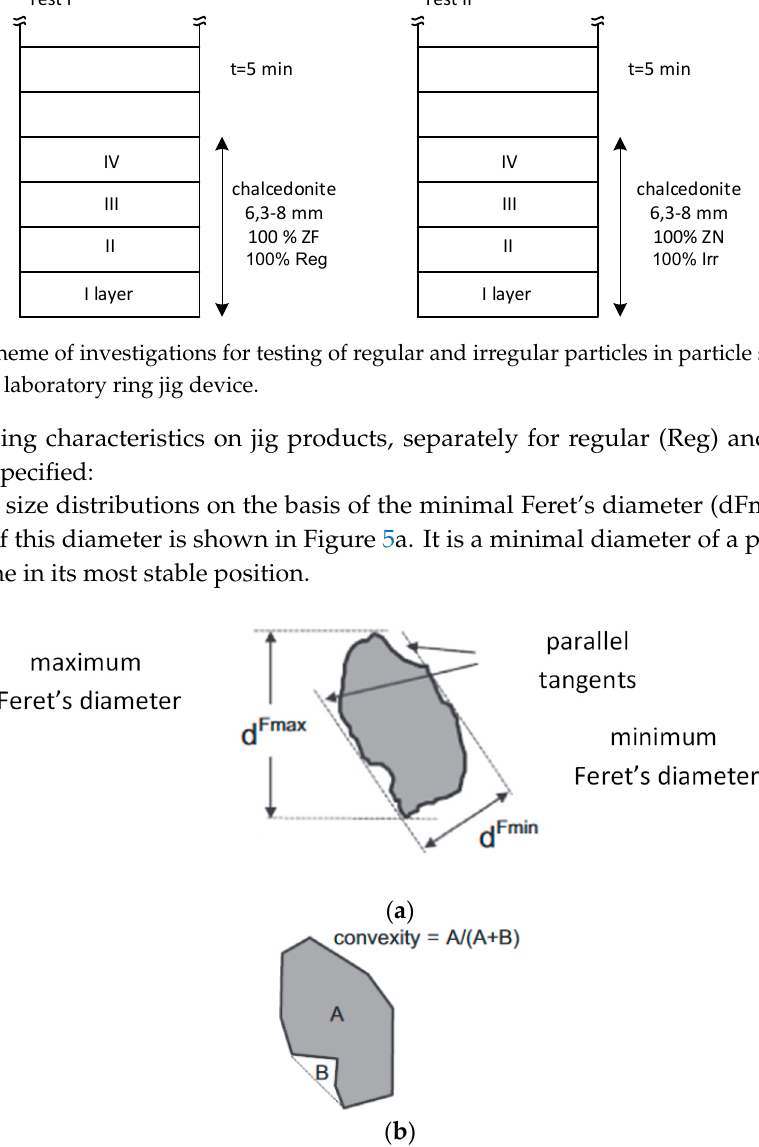
Figure 5. ( a ) Idea of Ferets’ diameters; dFmin—minimal Feret’s diameter, dFmax—maximum Feret’s diameter [38]. ( b ) Particle convexity; A—convex surface of the particle, B—concave surface of the particle [38].